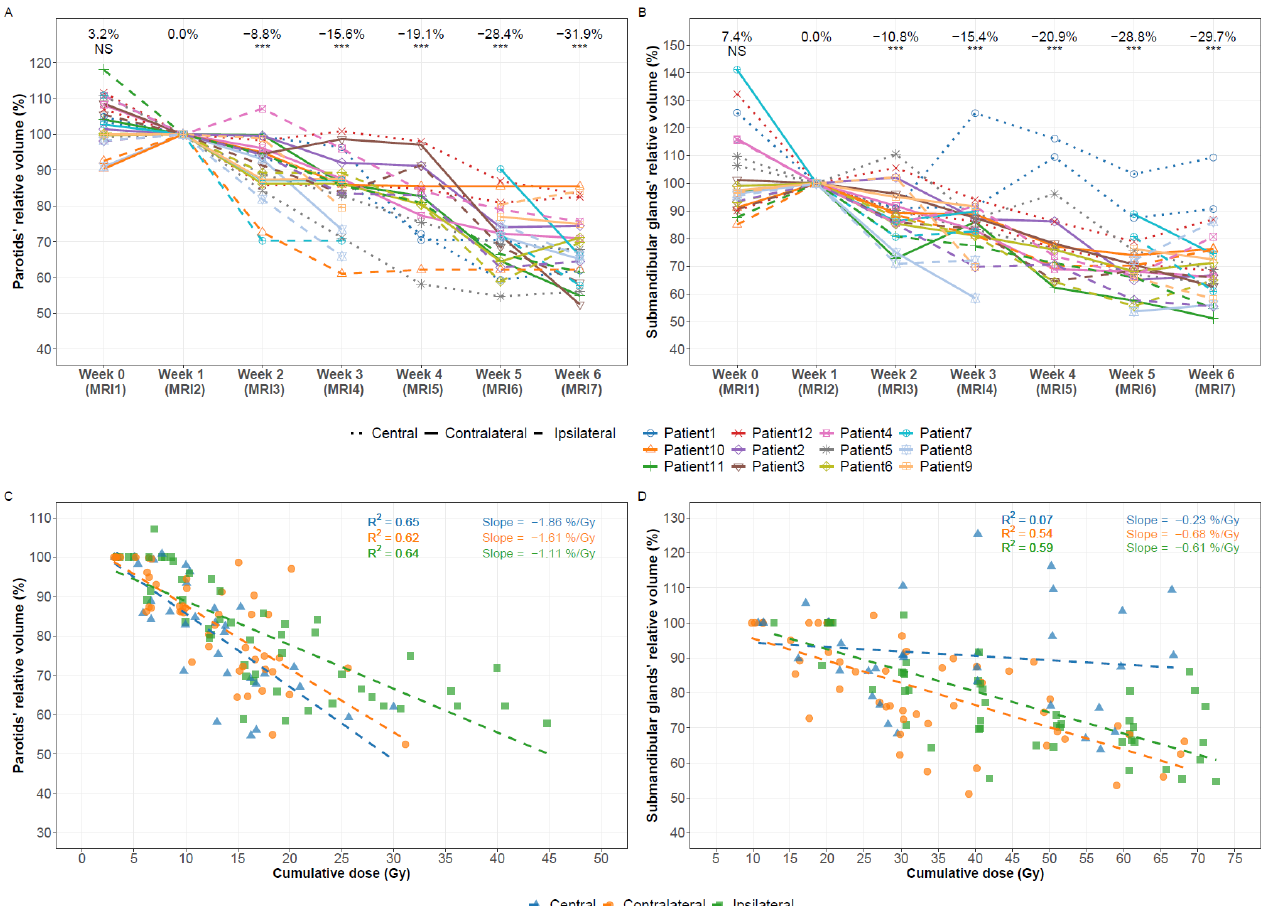
Figure 3. Volume changes of the salivary glands during treatment and the relationship of volume change with the cumulative dose for the respective gland. MRI2 acquired immediately before delivery of the first fraction was set as reference. ( A ) Volume changes of the parotid glands. ( B ) Volume changes of the submandibular glands. ( C ) Volume change of the parotids vs. the cumulative dose for the parotids at the time of volume measurement. ( D ) Volume change of the submandibular glands vs. the cumulative dose for the submandibular glands at the time of volume measurement. In case of a symmetric bilateral treatment of a centrally located tumor without clear lateralization, the term “central” was used to indicate the location of the salivary glands. NS: not significant, *** p < 0.001.